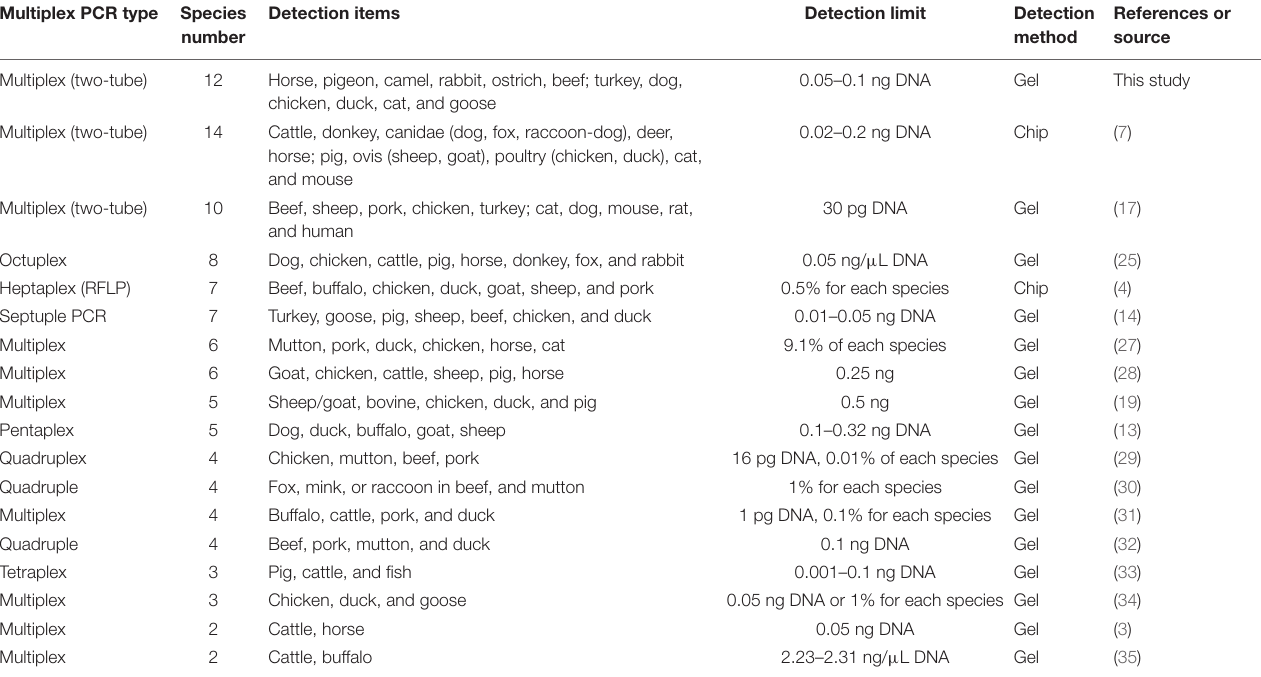
TABLE 3 | Comparative analysis of multiplex PCR assays for the identification of meat